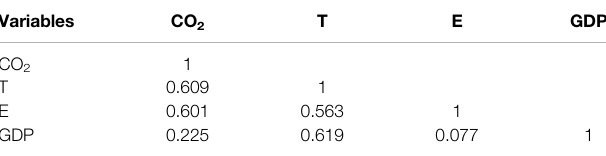
TABLE 4 | Correlation Latin American panel.